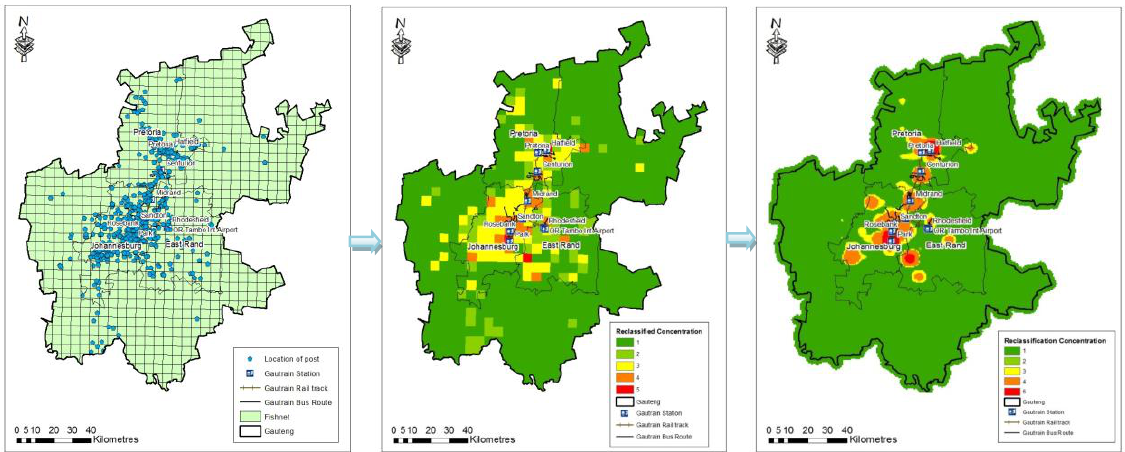
Figure 9: Gauteng fishnet and Focal statistics for